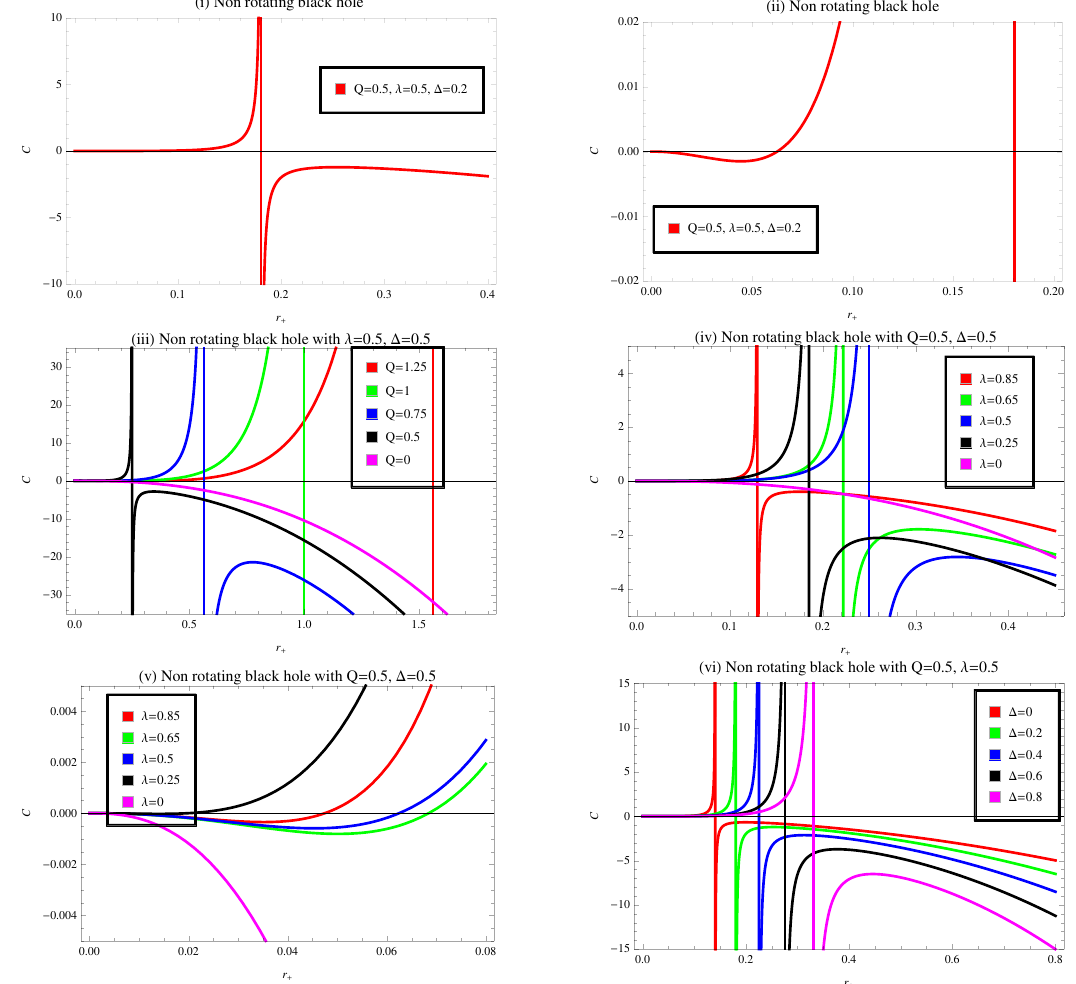
Figure 3. Plot of heat capacity C v versus horizon radius r + for static regular BH in the presence of CMG